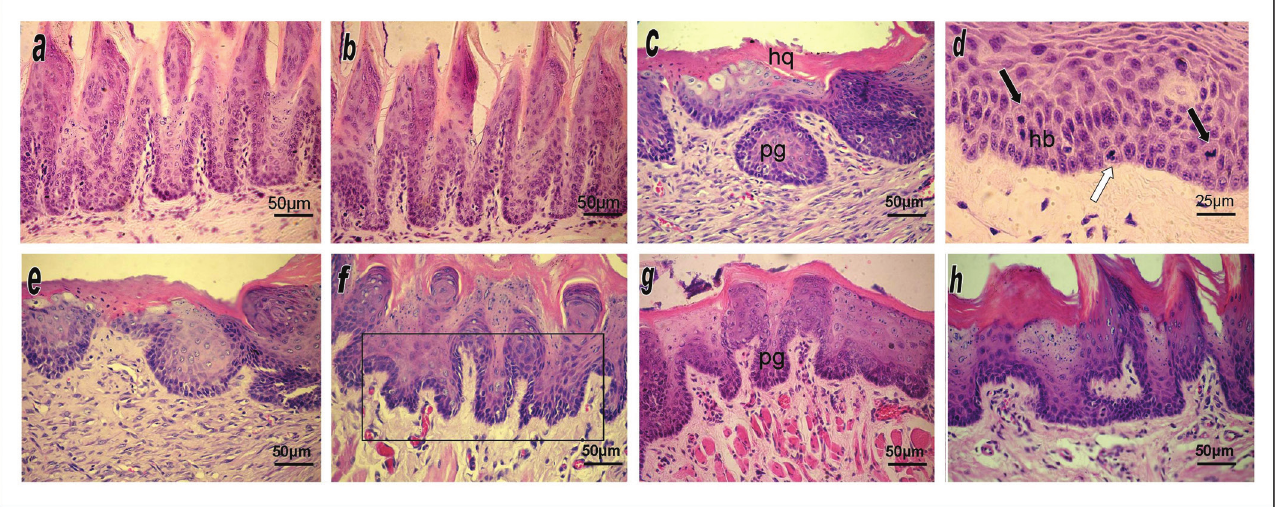
Figure 1. HE stained histological sections of the mucosal lining epithelium of the border of the tongue in experimental animals. (a) and (b) Negative control groups (CTR1 and CTR2) showing a normal epithelium. (c) Group TUM1 showing a hyperkeratinized epithelium (HQ) with dysplasia; note the droplet-shaped entrapped papillae (pg). (d) Group TUM1 showing moderate cell pleomorphism and hyperchromatic vell nuclei, evident basilar hyperplasia (hp) and basal mitosis (light arrow) and suprabasal mitosis (dark arrows). (e) Group TUM2 showing epithelium with dysplasia extending to the middle third, similar to TUM1. (f) Group PROP1 showing nuclear hyperchromatism in epithelial cells, highlighting droplet-shaped irregular papillae (Frame). (g) Group PROP2 showing rare and focal atypical findings expressed as discreet droplet-shaped papillae (pg) and mild nuclear hyperchromatism. (h) Group PROP3 showing only mildly disarrayed architecture of epithelial papillae and mildly hyperchromatic cell